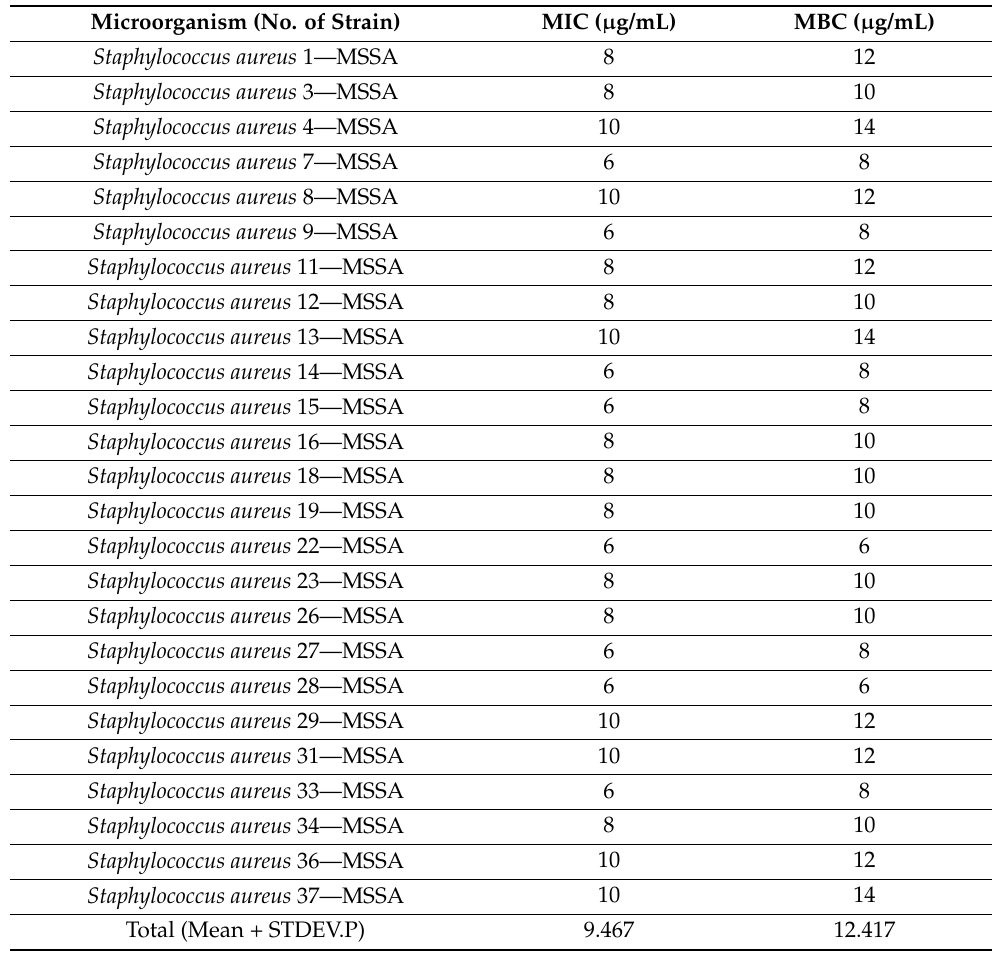
Table 4. Staphylococcus aureus MSSA strains are susceptible to EERP (MIC and MBC and Mean + STDEV.P values in µ